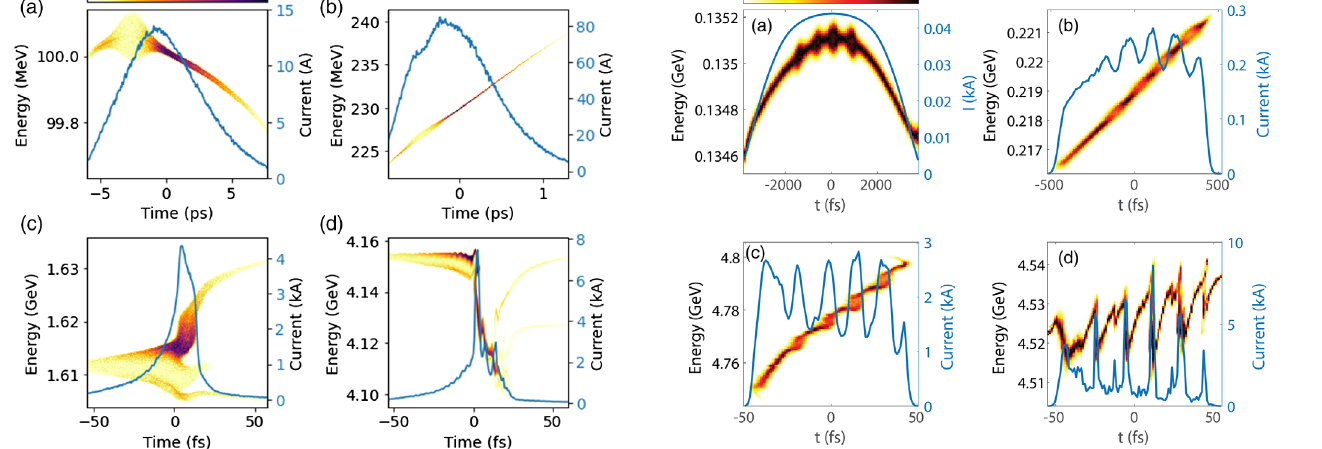
FIG. 6. Generation of a single high-current spike at the LCLS-II scS beamline. Longitudinal phase space: (a) after laser heater; (b) after the first bunch compressor; (c) after the second bunch compressor; (d) at the entrance of soft x-ray undulator. The colorbar above (a) shows the relative density for each plot. See